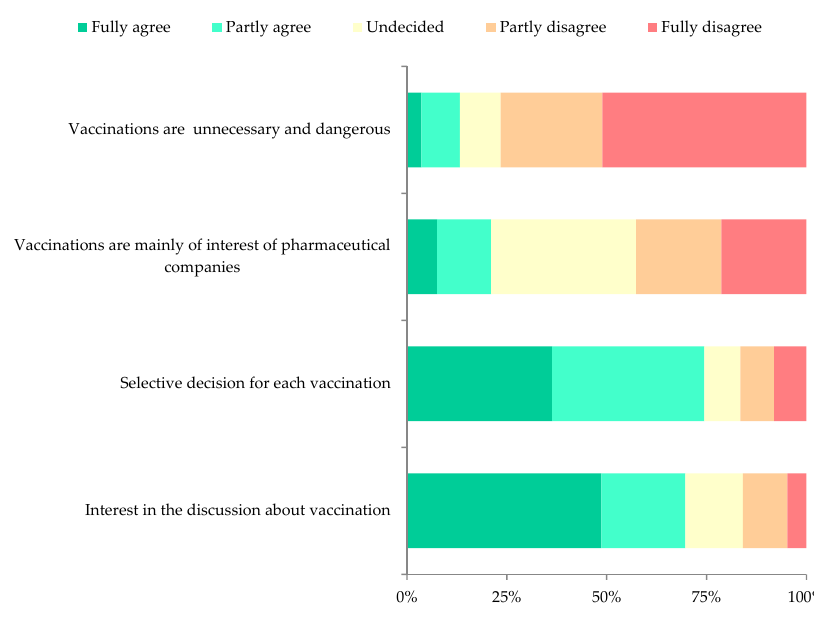
Figure 2. Distribution of vaccine hesitancy determinants.